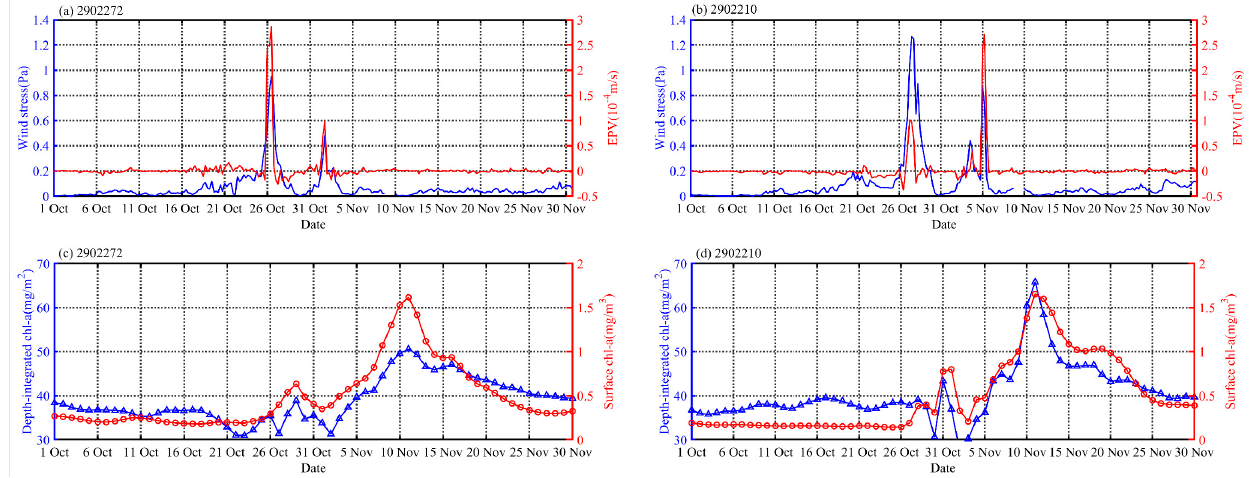
Figure 12. Time series of wind stress and EPV ( a , b ), and depth-integrated chl-a and surface chl-a ( c , d ) based on the biogeochemistry model product in October and November in the areas of floats 2902272 and 2902210.